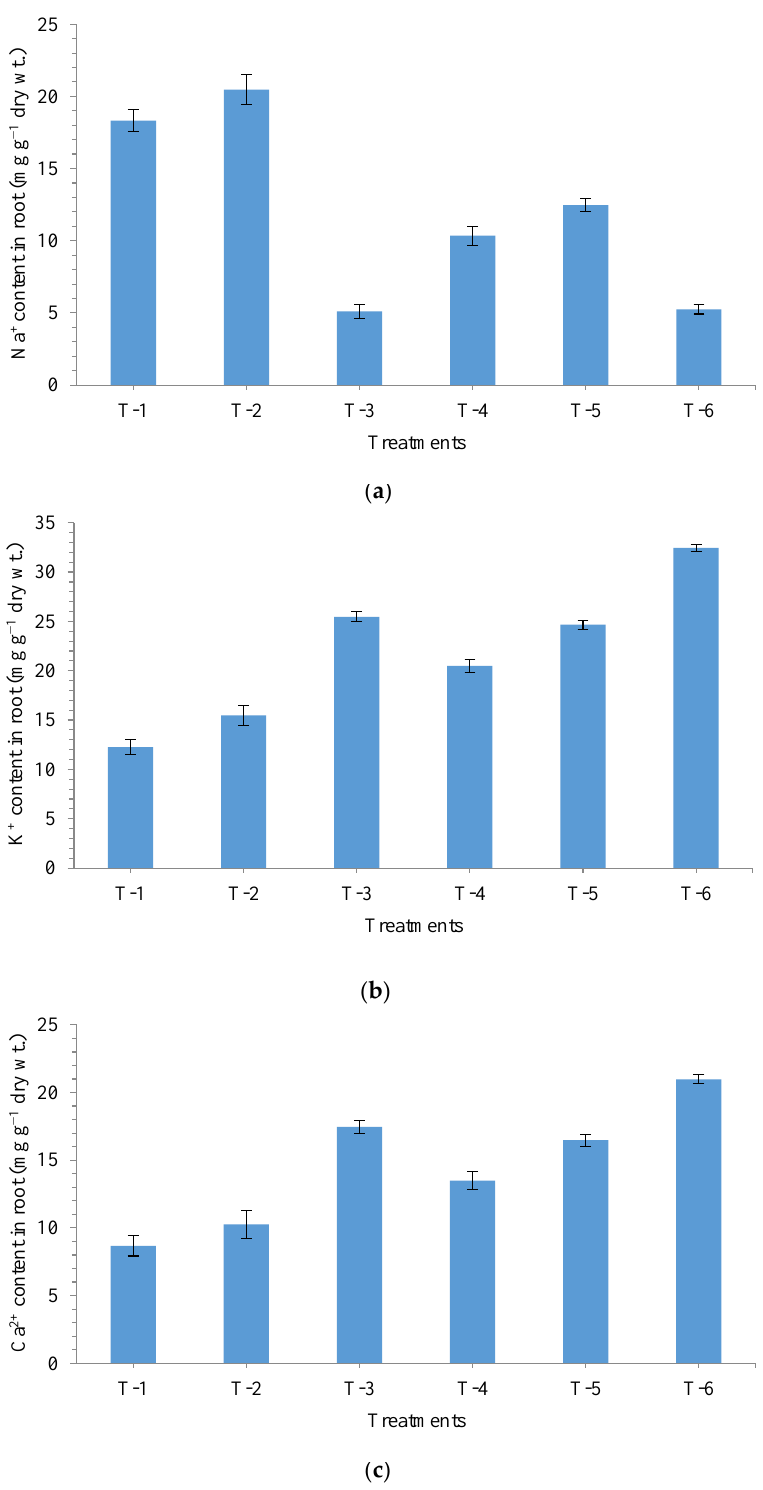
Figure 7. Effects of seed bio-priming on uptake of cations ( a ) Na + content in roots, ( b ) K + content in roots, and ( c ) Ca 2+ content in roots at 30 days after sowing. Treatments were: T 1 -Saline sodic soil (Negative control), T 2 -Non-saline sodic soil + Salt (NaCl 150 mM), T 3 -Non-saline sodic soil (Positive control), T 4 -Saline sodic soil + Pseudomonas geniculata MF-84, T 5 -Non-saline sodic soil + Salt (NaCl 150 mM) + Pseudomonas geniculata MF-84 and T 6 -Non-saline sodic soil + Pseudomonas geniculata MF-84. Data are mean ± SEM ( n = 5).